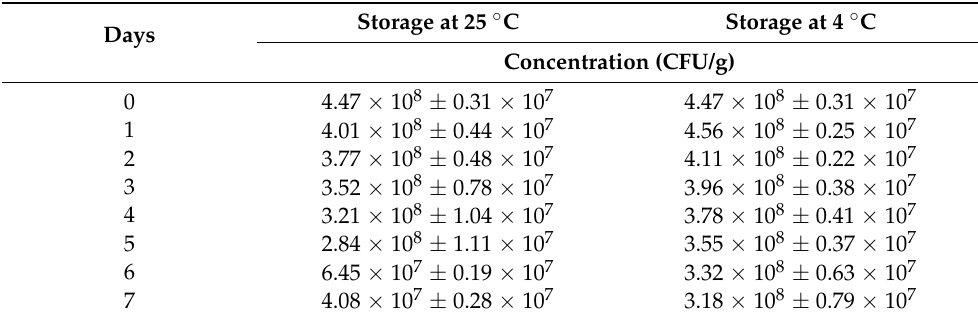
Table 1. The variation of L. fermentum SWP-AFFS02 level in LAB feed after storage for 7 days at 25 ◦ C or 4 ◦ C.